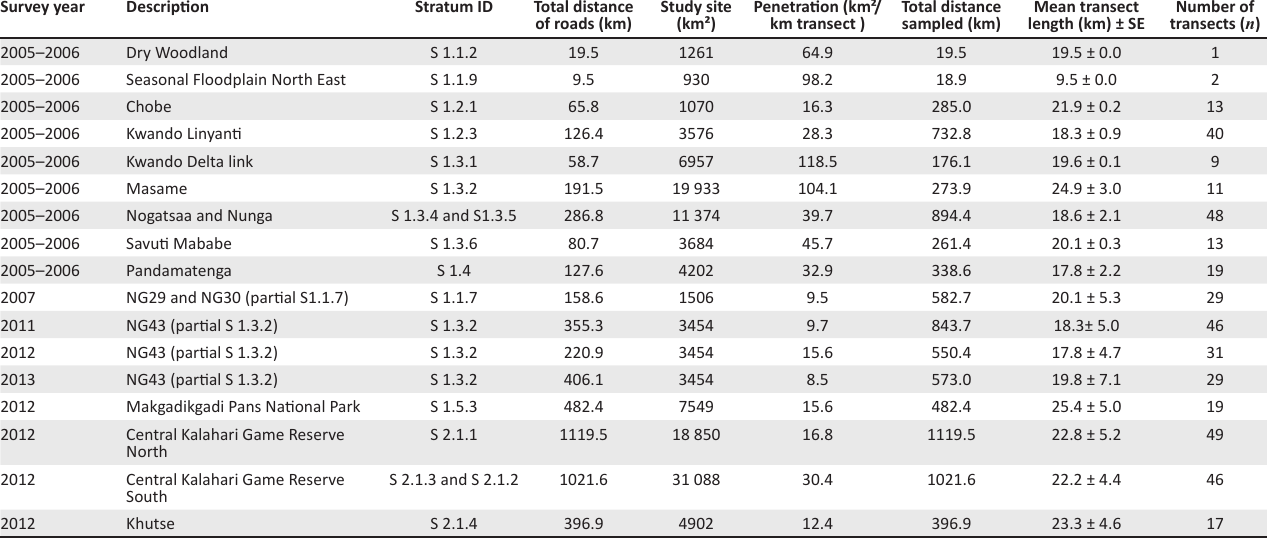
TABLE 1: Summary of track surveys completed between 2005 and 2013 to estimate brown hyaena ( Parahyaena brunnea ) densities in study areas across Botswana. Survey year